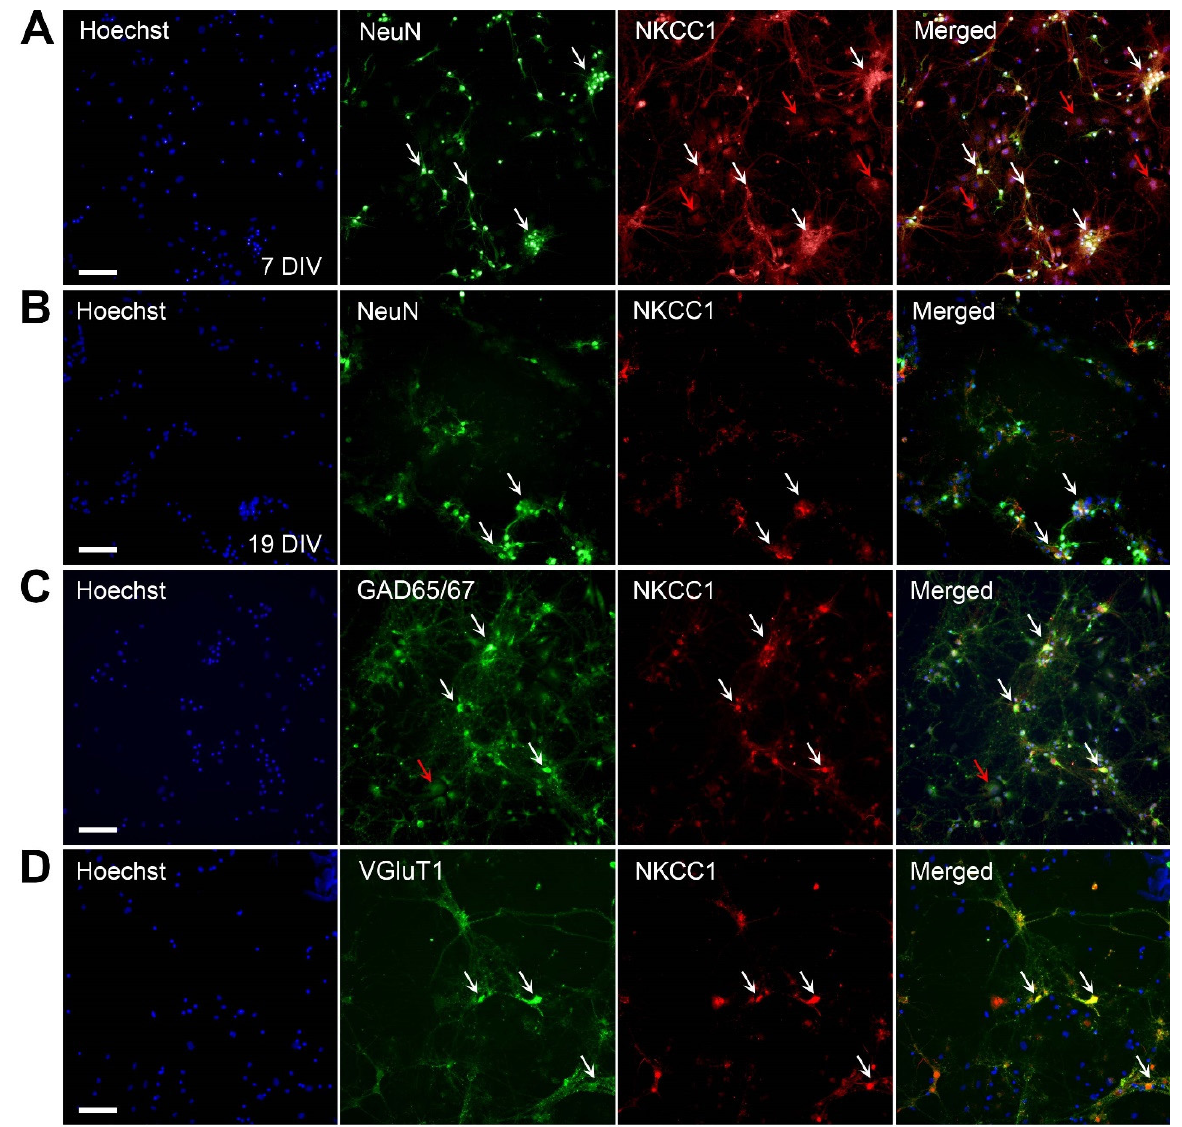
Figure 2. NKCC1 is expressed by primary hippocampal neurons. ( A ) Neurons labeled at 7 DIV; ( B ) Neurons labeled at 19 DIV. Primary hippocampal neurons double-labeled for the neuronal marker, NeuN (green), and NKCC1 (red) show neuronal expression of NKCC1. White arrows indicate colocalization of NKCC1 to neurons (yellow). ( C ) NKCC1 expression in GABAergic neurons. Primary mouse hippocampal neurons at 7 DIV were double-labeled with the GABAergic marker, GAD65/67 (green), and NKCC1 (red). White arrows indicate colocalization of KCC2 to GABAergic neurons (yellow). ( D ) NKCC1 expression in glutamatergic neurons. Primary mouse hippocampal neurons at 7 DIV were double-labeled with the glutamatergic marker, VGluT1 (green), and KCC2 (red). Arrows indicate colocalization of NKCC1 to glutamatergic neurons (yellow). Red arrows indicate potential endothelial cells in culture. All cell nuclei are counterstained with Hoechst 33342 (blue). Scale bar = 100 µ